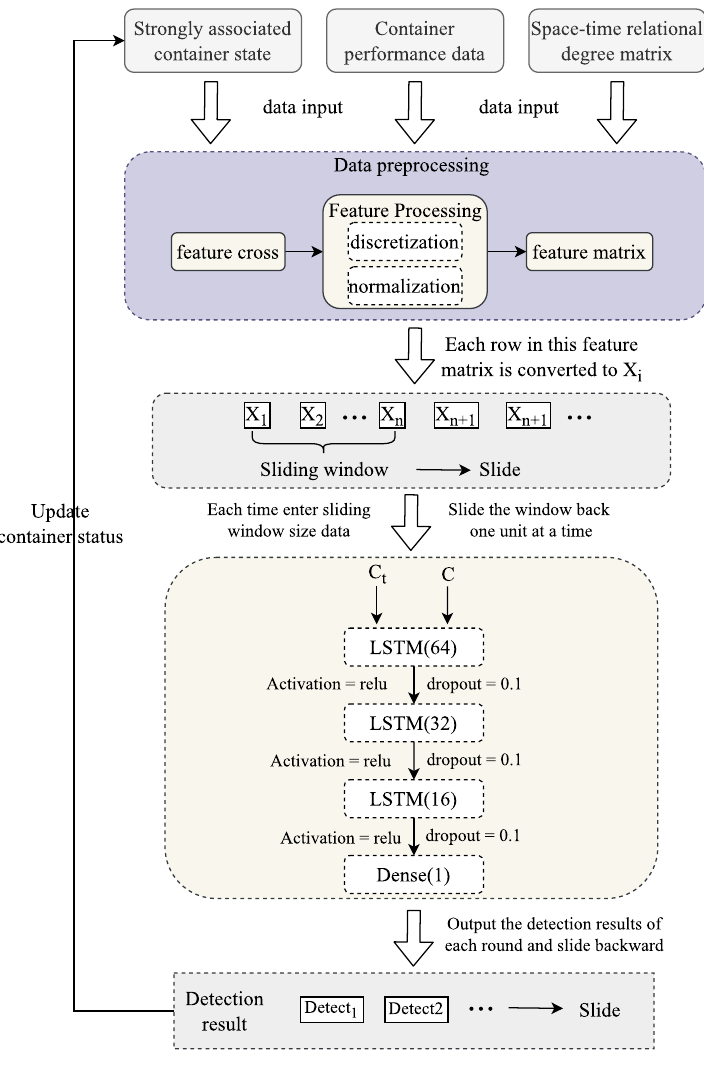
Evaluation of fault relational model The model is built and trained with the dataset of the Docker cluster obtained by simulation experiment. The LSTM training model is configured to train the fault correlation model with different network structures ranging from 4 to 8 hidden layers and from 8 to 256 hidden